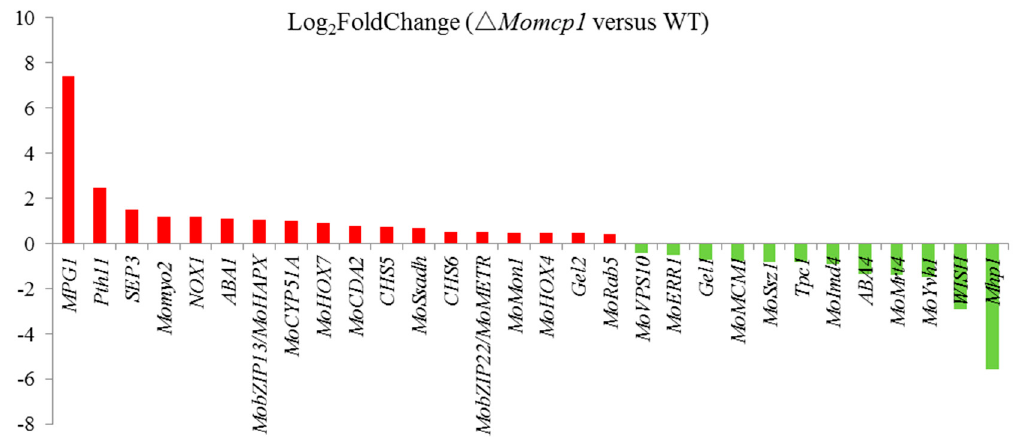
Figure 6. The different expressions of pathogenicity genes in Mocmp1 mutants compared with WT.